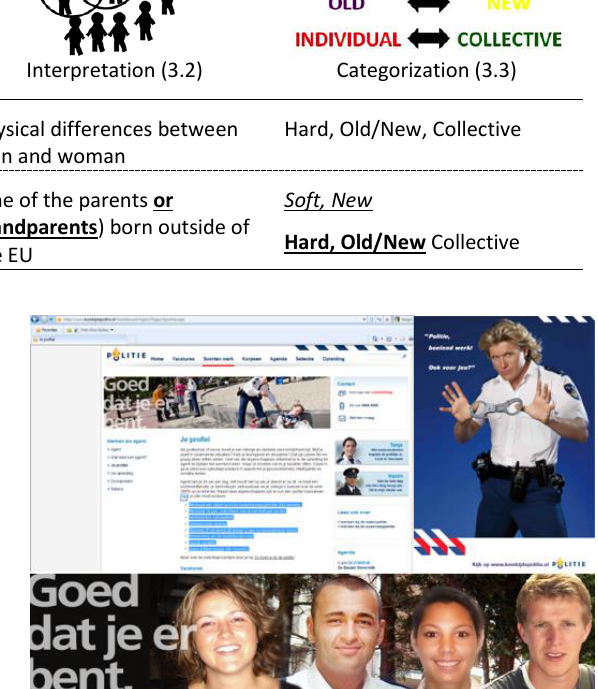
Figure 2. Diversity within the police force on the Dutch national recruitment